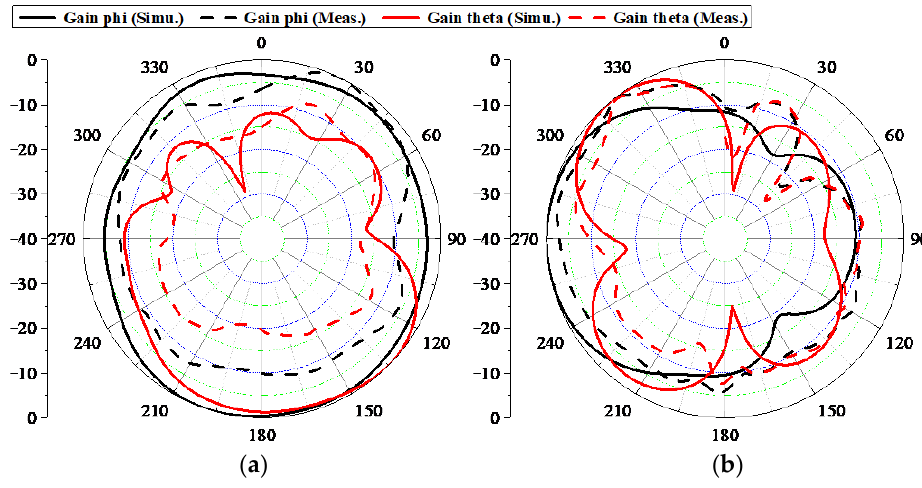
Figure 16. Measured 2D radiating pattern; ( a ) 3.5 GHz xoy plane. ( b ) 3.5 GHz xoz plane.